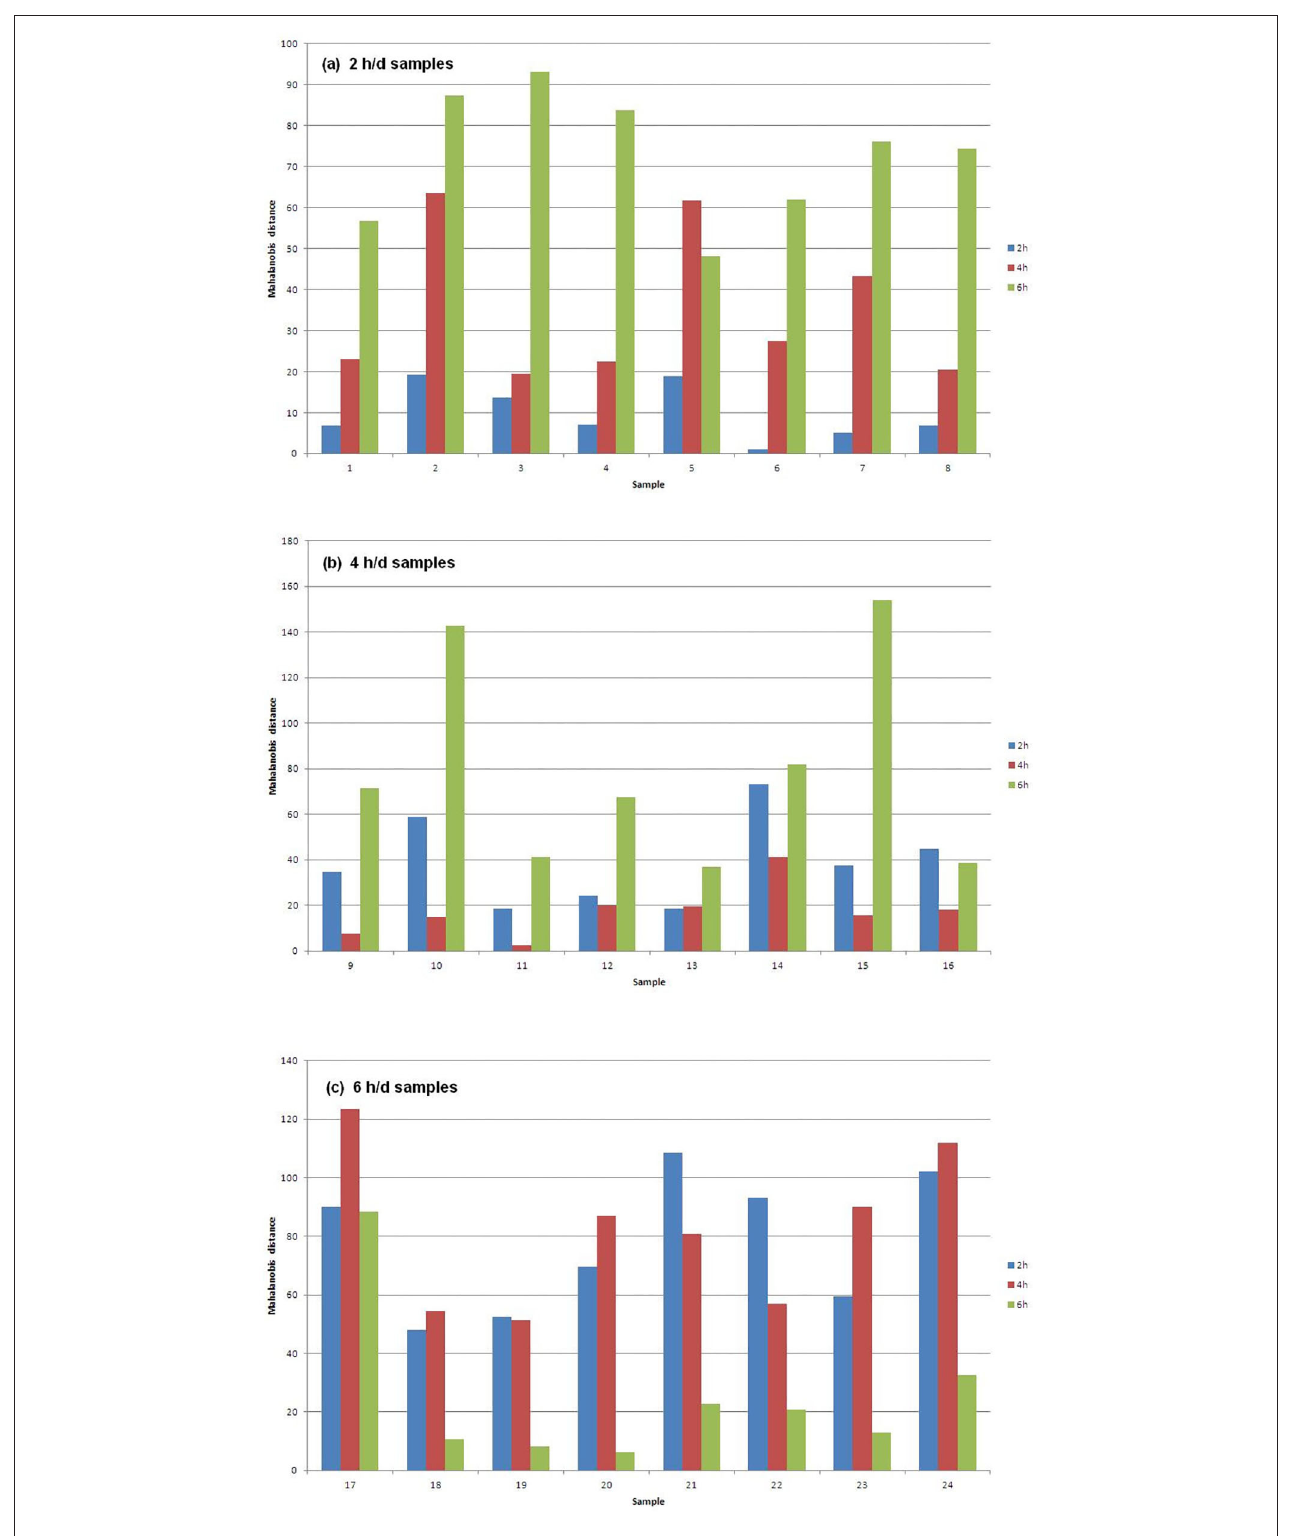
FIGURE 1 | Mahalanobis distances of the (a) 2, (b) 4, and (c) 6 h/d samples, from the centroids of the three treatment groups of samples.